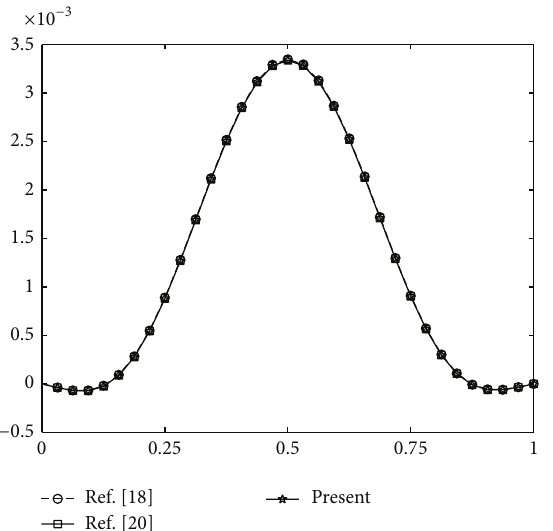
Figure 1: Numerical solutions at 𝑡 = 10 , ℎ = 1/32 , 𝜏 = 0.1 , 𝛽 = 1 , 𝛼 = 2 , and 𝑝 = 4 .